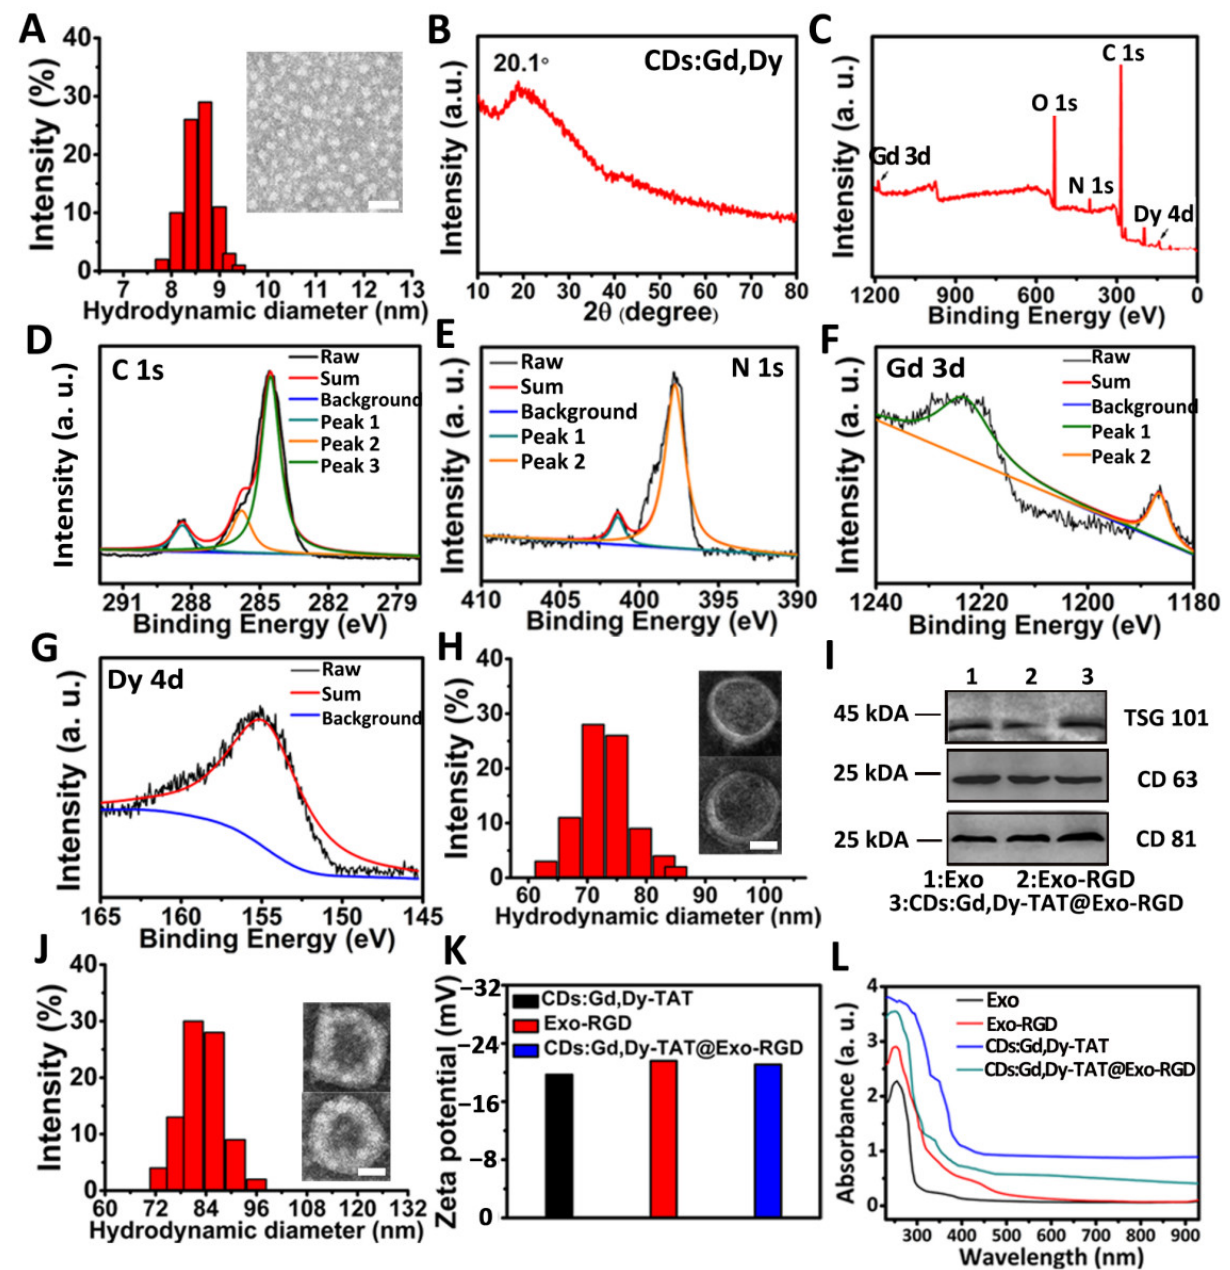
Figure 1. Preparation and characterization of CDs:Gd,Dy-TAT@Exo-RGD. ( A ) Hydrate particle size and representative TEM images (inset) of CDs:Gd,Dy, scale bar: 30 nm. ( B ) XRD pattern of CDs:Gd,Dy. ( C ) XPS spectrum of CDs:Gd, Dy. High resolution XPS spectra of C 1s ( D ), N 1s ( E ), Gd 3d ( F ) and Dy 4d ( G ). ( H ) Hydrate particle size and representative TEM images (inset) of Exo-RGD, scale bar: 30 nm. ( I ) Western blot qualitative analysis of TSG101, CD63 and CD81. ( J ) Hydrate particle size and representative TEM images (inset) of CDs:Gd,Dy-TAT@Exo-RGD, scale bar: 30 nm. ( K ) Zeta potentials analysis of CDs:Gd,Dy-TAT, Exo-RGD and CDs:Gd,Dy-TAT@Exo-RGD. ( L ) UV-Vis-NIR absorption spectra of Exo, Exo-RGD, CDs:Gd, Dy-TAT and CDs:Gd,